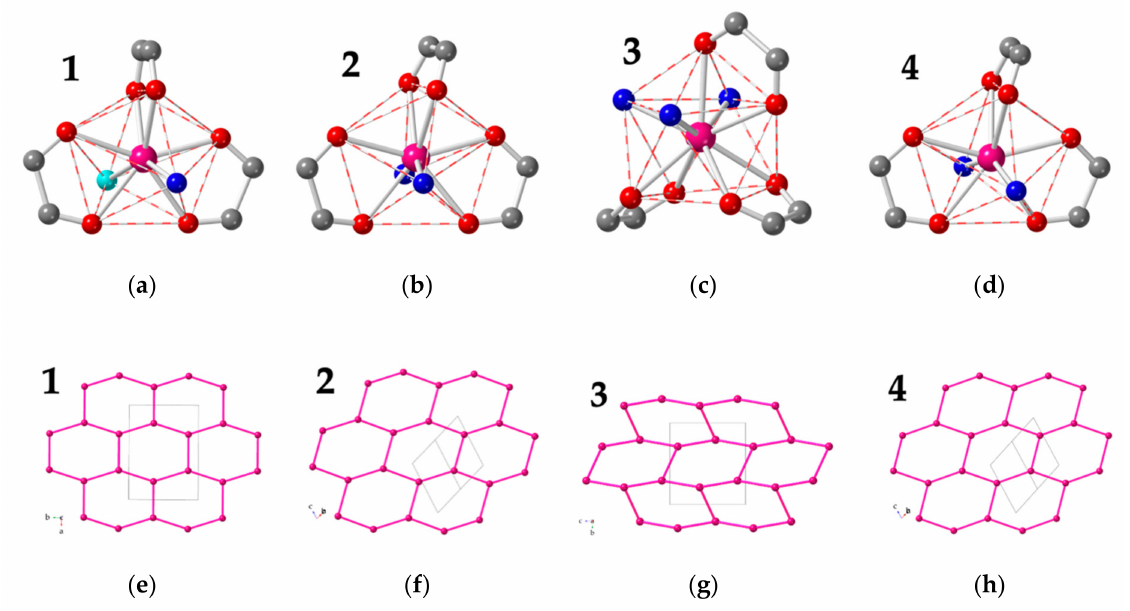
Figure 7. ( a – d ) Coordination polyhedra of compounds 1 – 4 . Colour code: Dy = pink, C = grey, O anilato = red, O water = light blue, O dmso = dark blue. ( e – h ) Schematic view of the layers in compounds 1 – 4 . Only the Dy atoms are shown for clarity. The pink lines represent the anilato